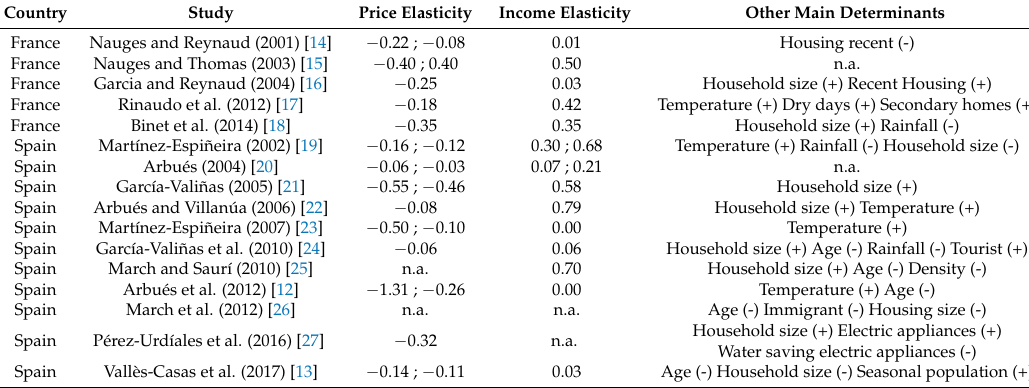
Table 1. Price, income and main determinants of household water demand in France and Spain.